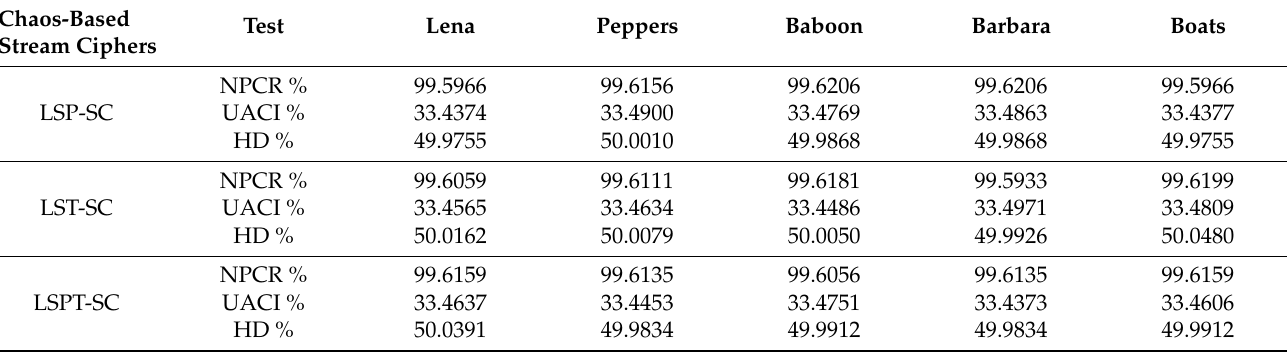
Table 8. NPCR, UACI, and HD values.